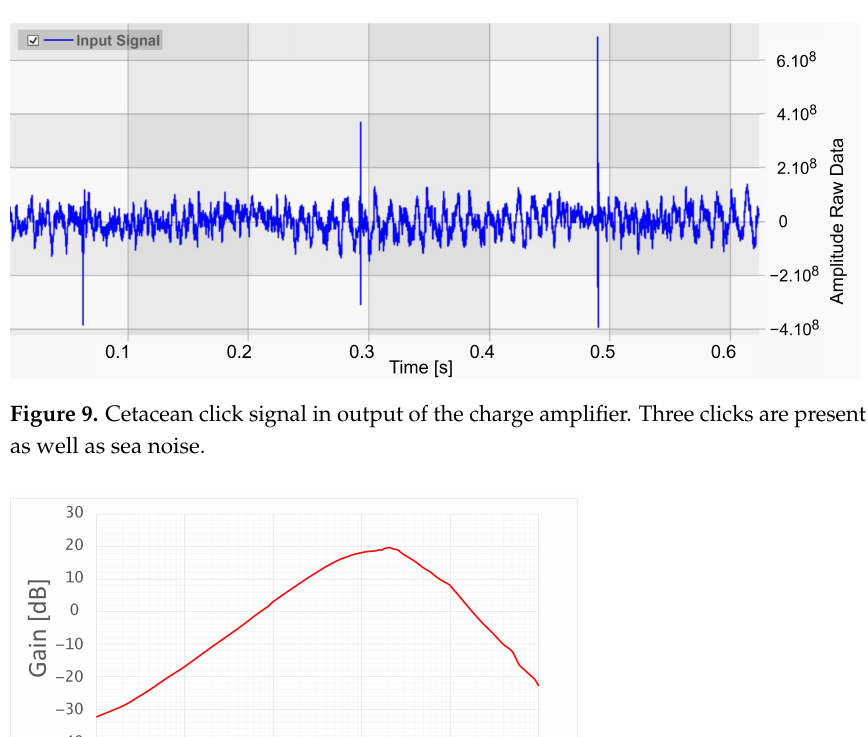
Figure 8. Electronic circuit of the always-on wake-up. ultra-low power parts are in green, low-power digital parts are in yellow. Voltage regulator and 1.65 V reference are not presented.